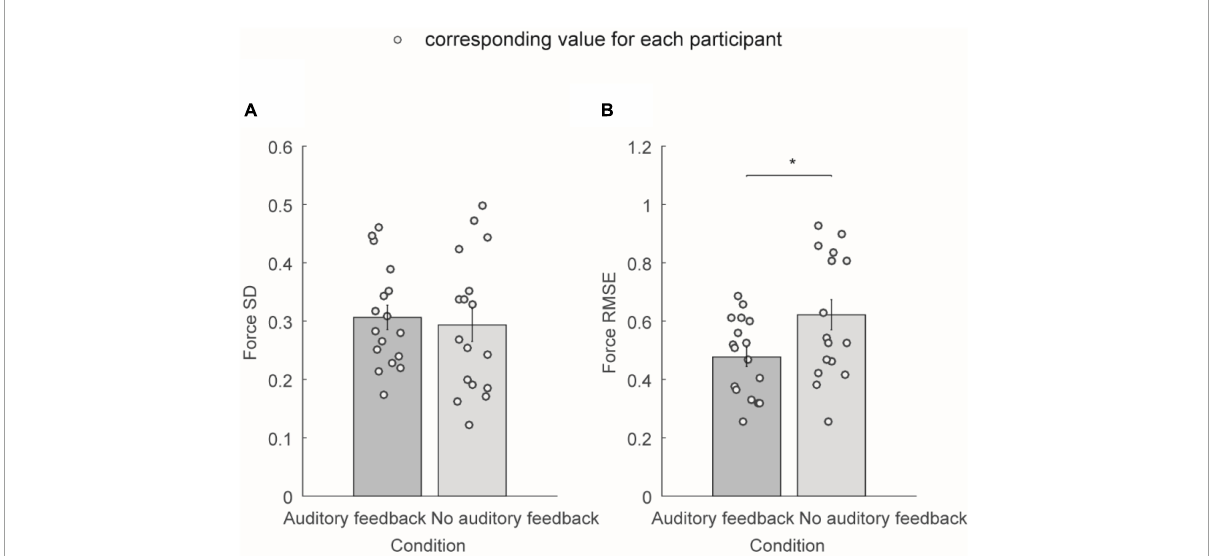
FIGURE4 The average force SD and average force RMSE of all the participants ( N = 17) in auditory feedback and no auditory feedback conditions. (A) The average force SD in the auditory feedback group and no auditory feedback group, the horizontal axis means the condition type, and the vertical axis means the average force SD. (B) The average force RMSE in the auditory feedback group and no auditory feedback group, the horizontal axis means the condition type, and the vertical axis means the average force RMSE. The empty circles mean the corresponding value for each participant. The data were presented as mean ± SEM. * p < 0.05. SEM, standard error of the mean; SD, standard deviation; RMSE, root mean square error.